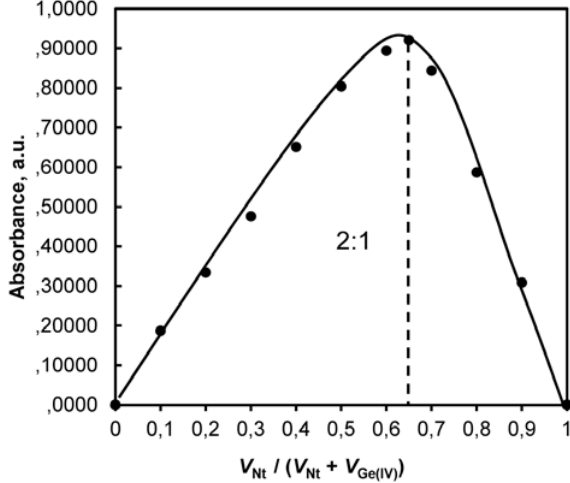
Figure 5. Determination of the molar ratio (n) Ge(IV):Nt by the method of continuous variations. C C = 5.0 × 10 –4 mol L –1 ; pH = 4.0; λ = 405 nm; τ = 2 4-NC